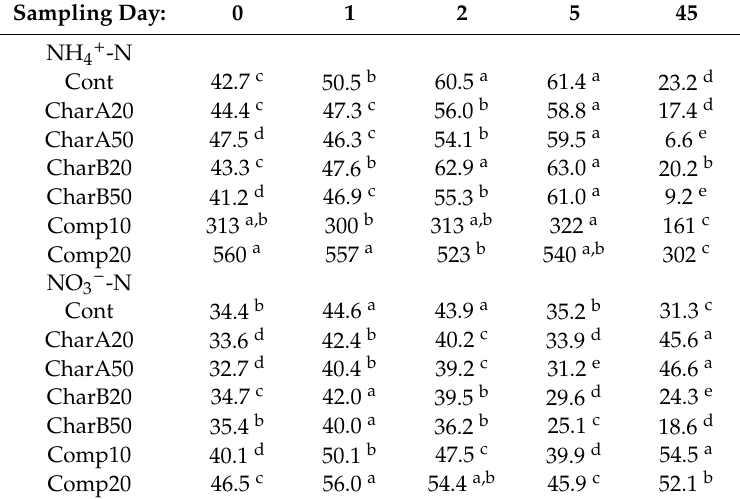
Table 5. Change in NH 4 + -N and NO 3- -N contents (mg N kg − 1 ) in soil amended with Biochar A, Biochar